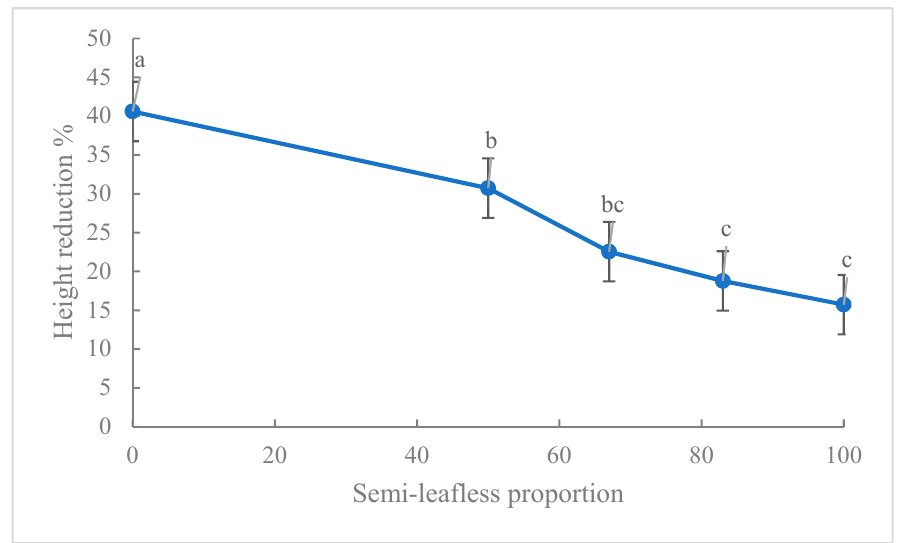
( b ) Figure 4. Validation of the image-derived heights to the ground measured heights in the testing datasets: ( a ) correlation between actual canopy heights and image-derived canopy heights taken on the same date; ( b ) correlation between actual plant heights and maximum heights. The image canopy heights were extracted in each imaged flight in each site-year (Fig- ure A1). The study analyzed the percentage of height reduction and reported significant variety and mixing ratio effects (Table 4). The height reduction by the interaction of vari- ety and ratio effects showed that the semi-leafless proportion increase had a lower reduc-